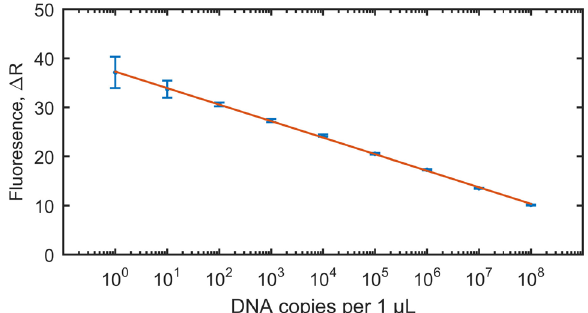
Figure 4. Standard curve generated from the amplification of nine dilutions of standard DNA in the range from one to 10 8 DNA copies per one μL; each dilution was run in triplicates and standard deviation for each dilution was calculated and displayed. The standard curve served for the quantification of initial copy numbers of T. gondii B1 gene in investigated wastewater and water samples collected from the area of Qinghai Province, P.R. China. Figure was prepared using MATLAB